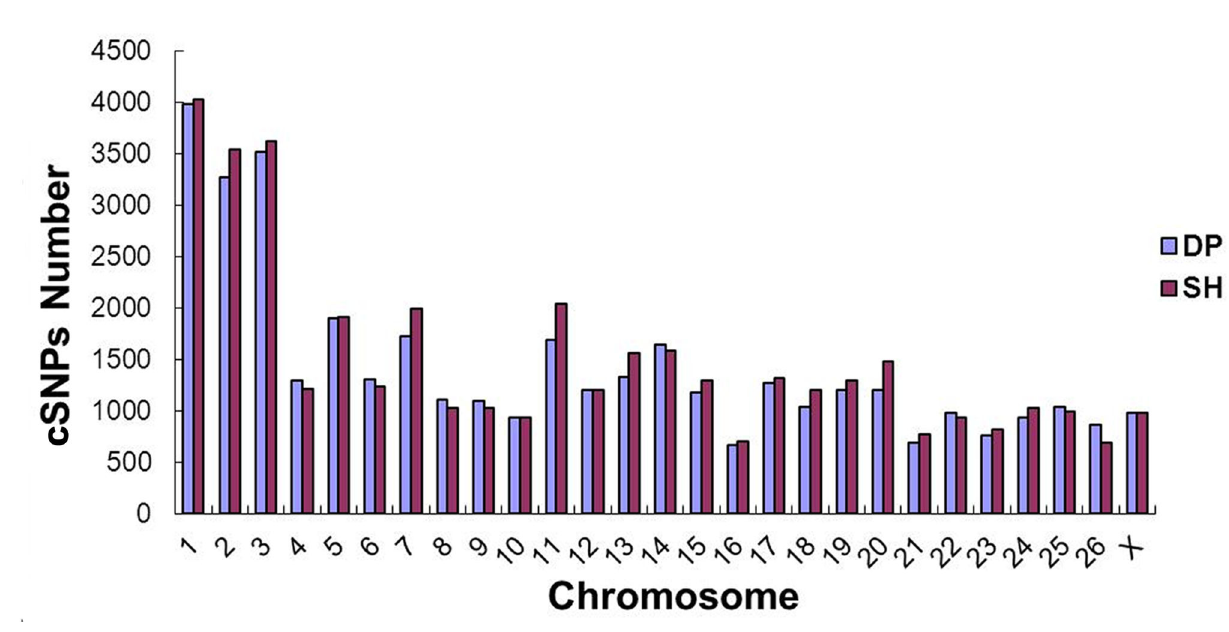
Figure 6. The distribution of cSNPs in the Ovis aries genome. The distribution of 79,332 putative cSNPs on the 26 sheep autosomes and the X allosome according to the two sequencing datasets are shown. All of the cSNPs distributed primarily on chromosomes 1, 2 and